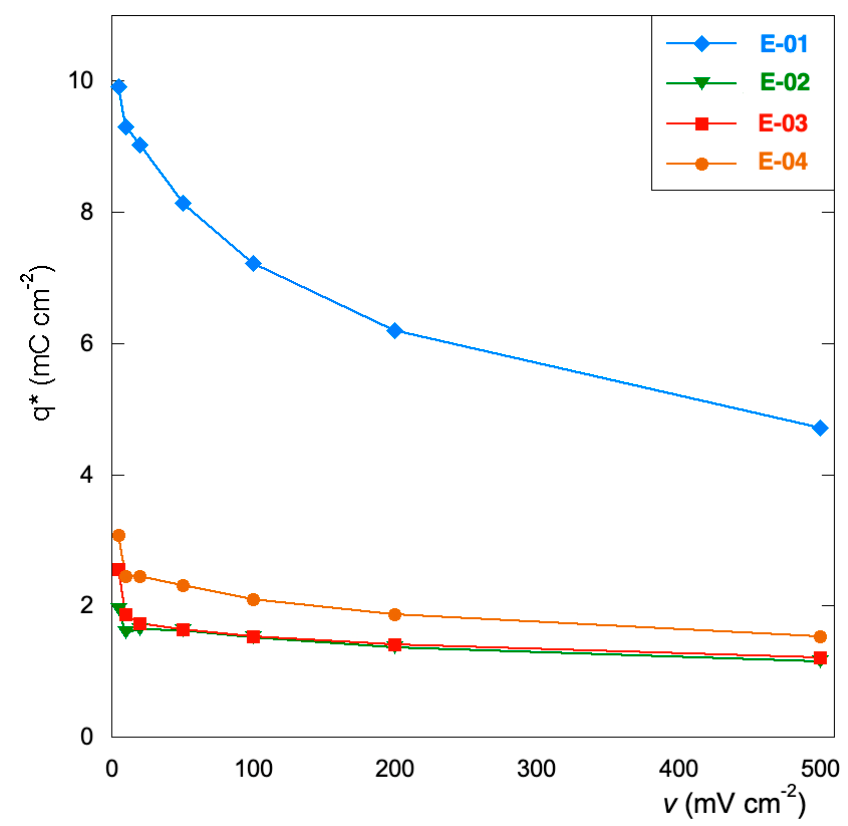
Figure 4. Voltammetric charge (q*) as a function of the scan rate values.